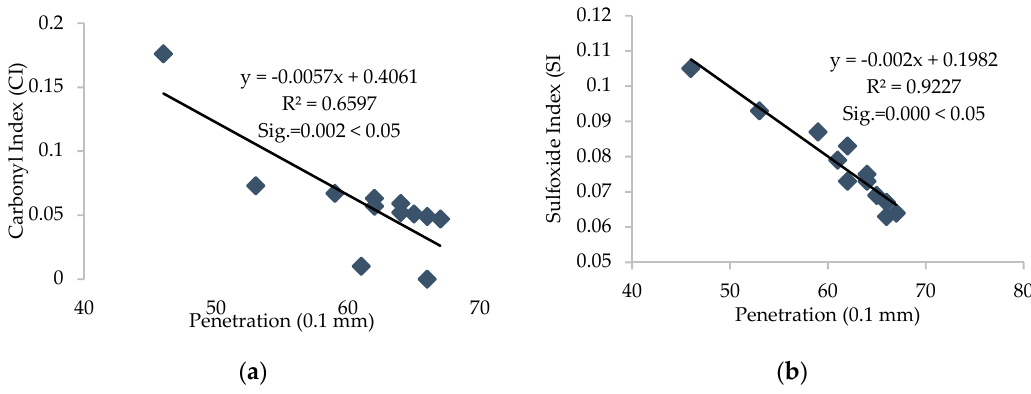
Figure 11. ( a ) Correlation between FTIR indices and ( b ) penetration values of all samples of binders.